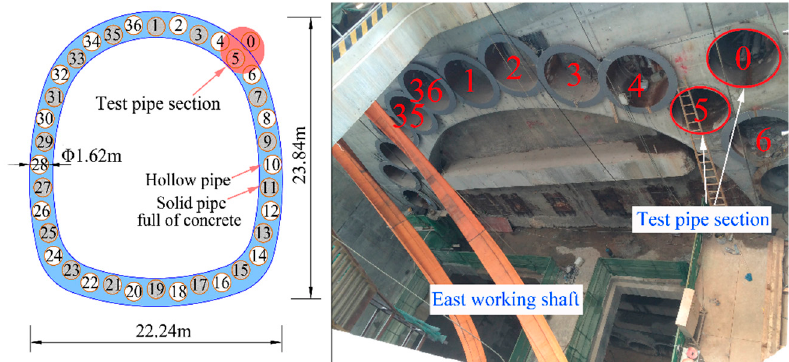
Figure 3 . Arrangement of the pipe-roofing. Figure 3. Arrangement of the